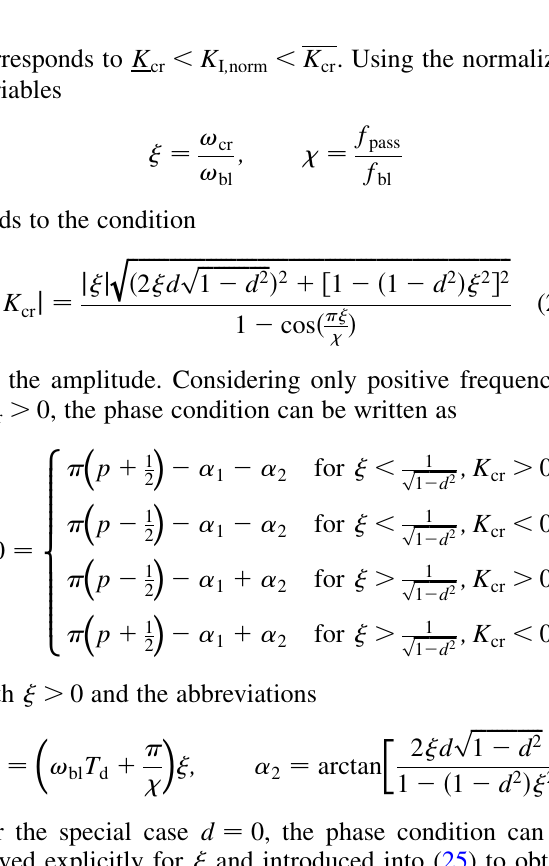
FIG. 7. Bode plot of the open-loop frequency